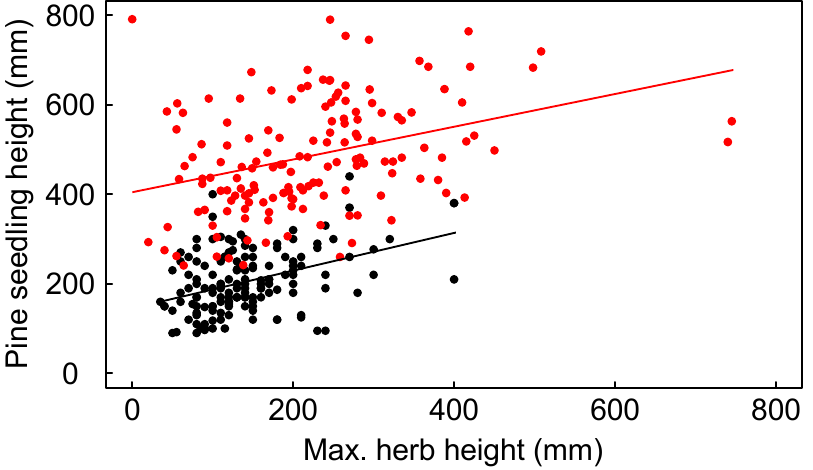
Figure 2. Correlation between the height of pine seedlings and the maximum height of the herbaceous layer at the beginning of the sampling season (May, Year 2, and May, Year 4) in a 50 cm diameter around them in the unweeded treatment. The lines show linear regressions for seedlings of age 2 (black) and 4 (red).